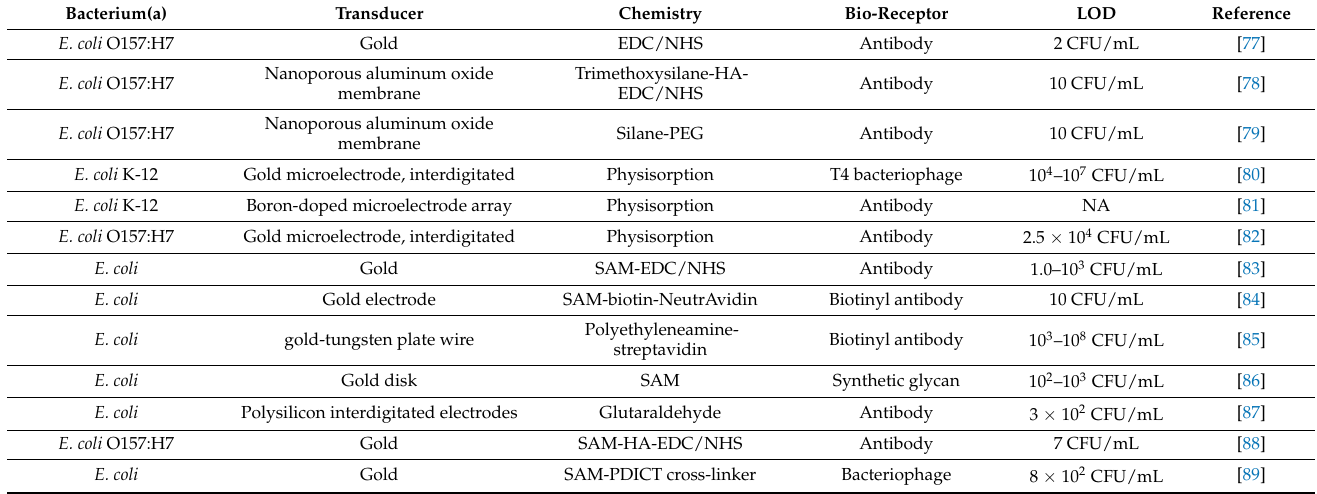
Table 1. Examples of microbial detection using nanomaterial-modified electrochemical